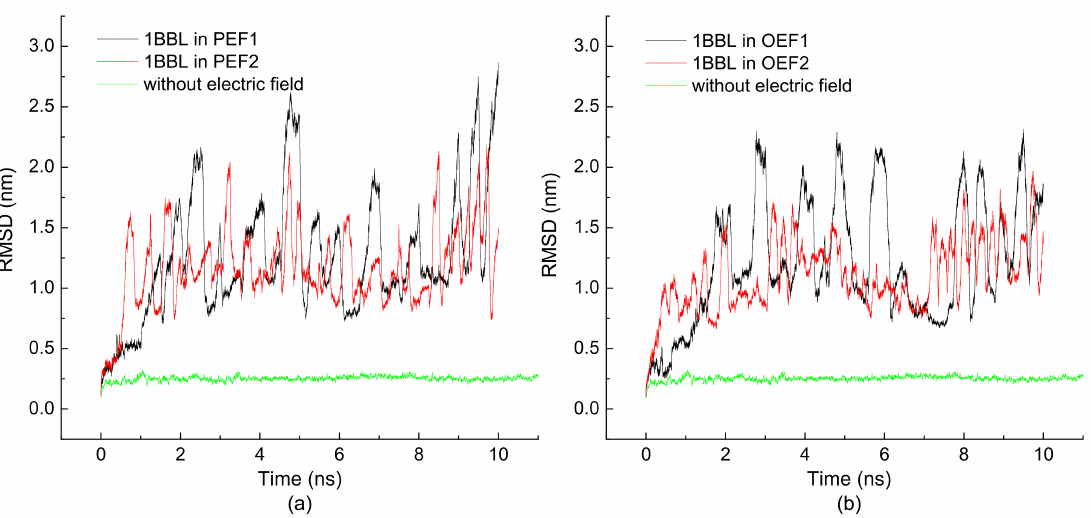
Figure 2. (Color online) Time evolution of the root mean square deviation (RMSD) of the protein 1BBL exposed in the ( a ) pulsed and ( b ) oscillating electric fields with a frequency of 1000/2000 MHz,